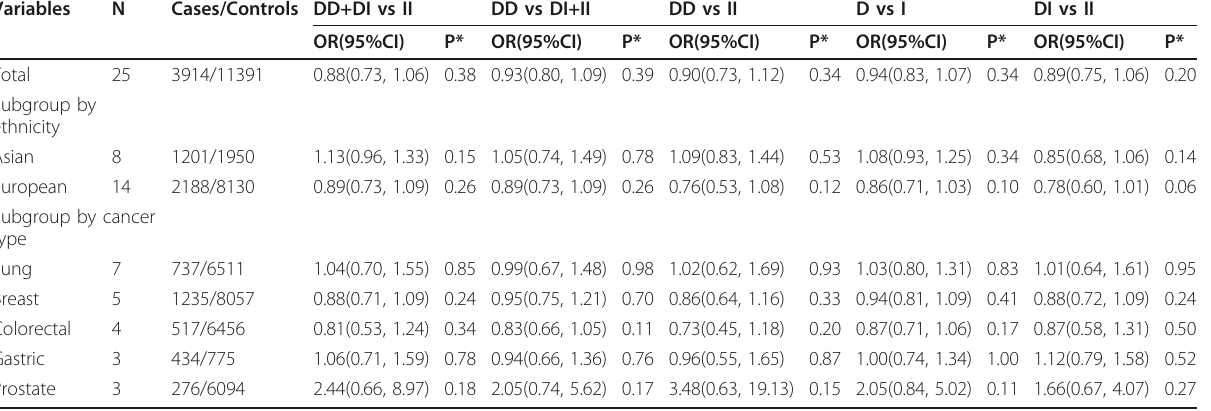
Table 3 Summary of different comparative results